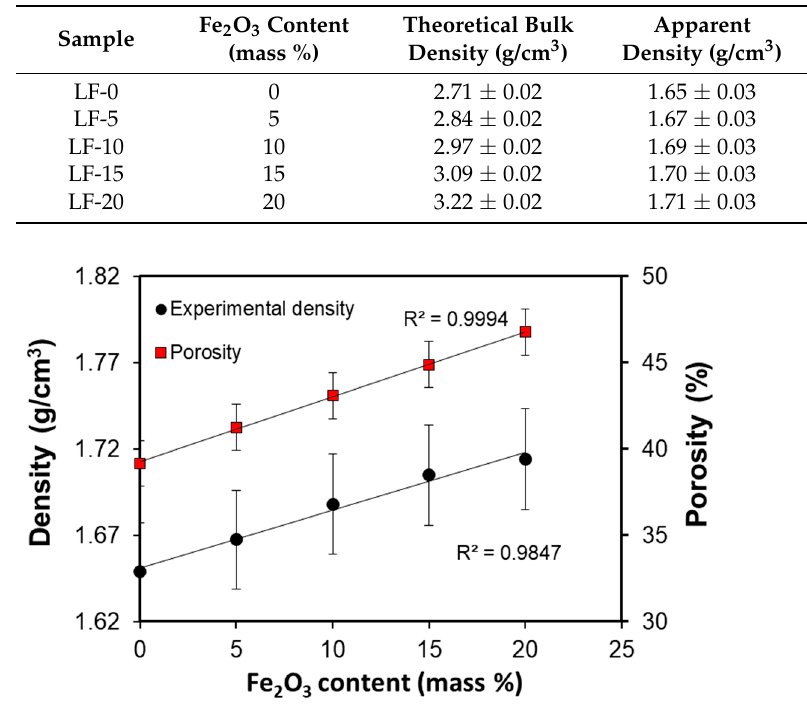
Figure 3. Apparent density and porosity versus Fe 2 O 3 content of the studied samples.